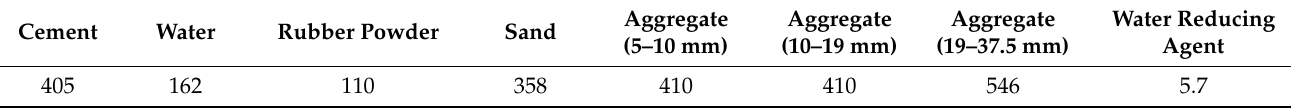
Figure 1. To facilitate construction and the installation of monitoring instrument, one side of the test section was a compacted earth shoulder. Table 1. Mixing proportion of rubberized concrete and ordinary concrete (kg/m 3 ).